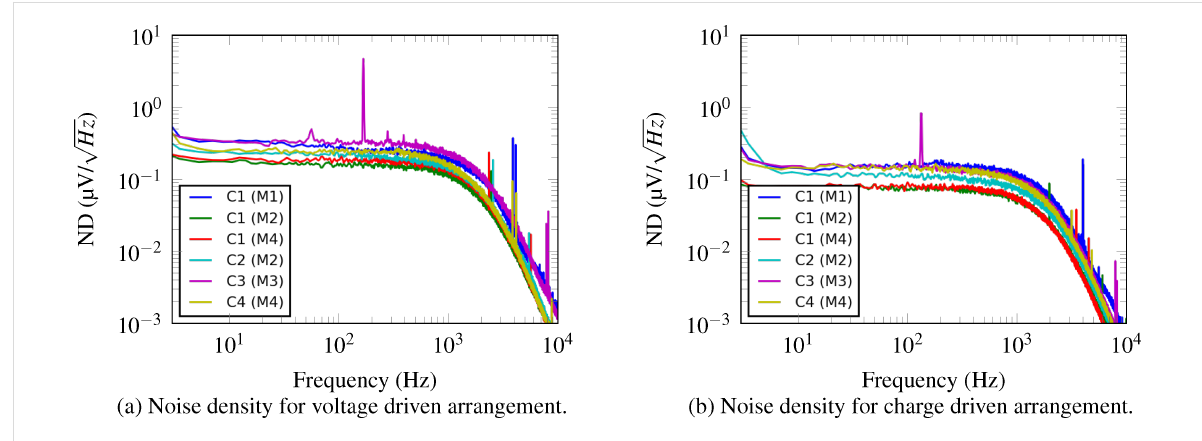
Figure 8: Amplitude noise density spectra of the output voltage V o for the reference cantilever C1 and optimized cantilevers C2–C4. (a) Voltage driven instrumentation, (b) charge driven instrumentation.